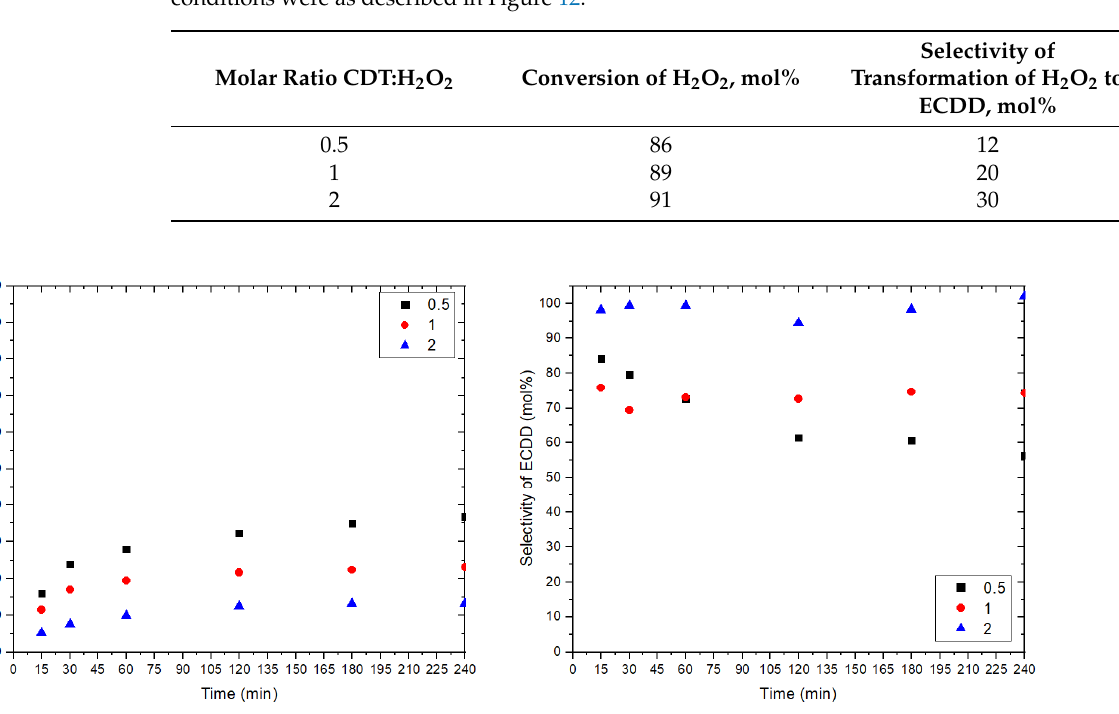
Figure 12. Conversion of CDT and selectivity of transformation of CDT to ECDD as a function of time for reactions performed with different CDT:H2O2 molar ratios. Reaction conditions: i-PrOH solvent, 80 wt%; catalyst, 5 wt%; temperature, 80 °C; mixing speed, 500 rpm. Table 2. Values of the conversion of H 2 O 2 and selectivity of transformation of H 2 O 2 to ECDD ob- tained after 4 h of performing the reaction with different molar ratios of CDT:H 2 O 2 . The reaction conditions were as described in Figure 12.